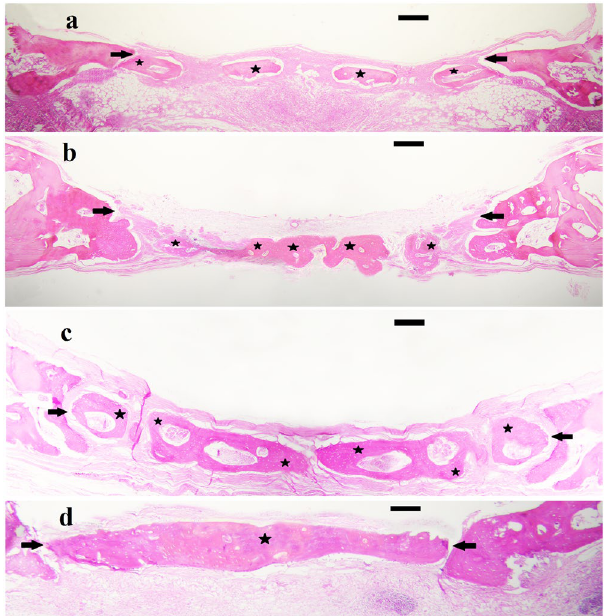
Figure 10. Hematoxylin and eosin staining of membrane coated defects using ( a ) PBSGL0 control, ( b ) PBSGL10, ( c ) PBSGL20, and ( d ) PBSGL40. The stars indicate the amount of newly formed bone two months after surgery in the surgical margins. Original magnification is × 40. Scale bars = 500 µ